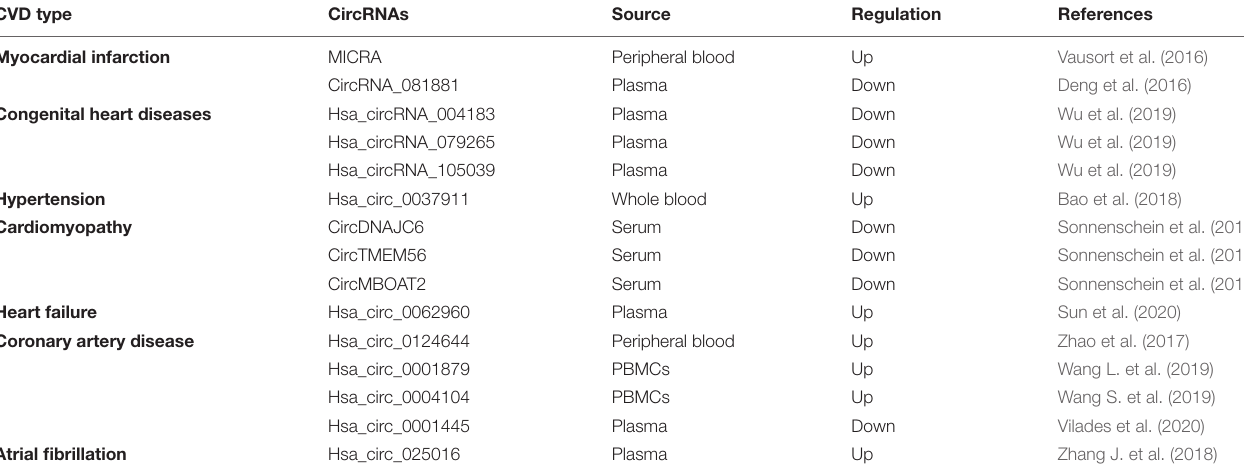
TABLE 3 | Circulating circRNAs as diagnostic biomarkers of